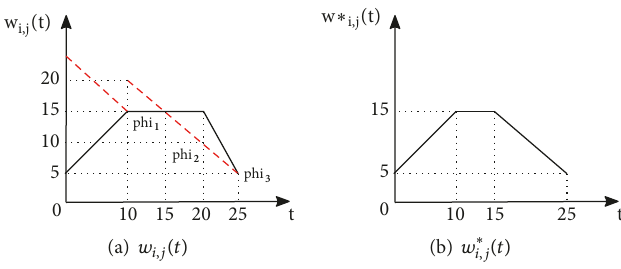
Figure 1: Computing 𝑤 ∗ 𝑖,𝑗 (𝑡)